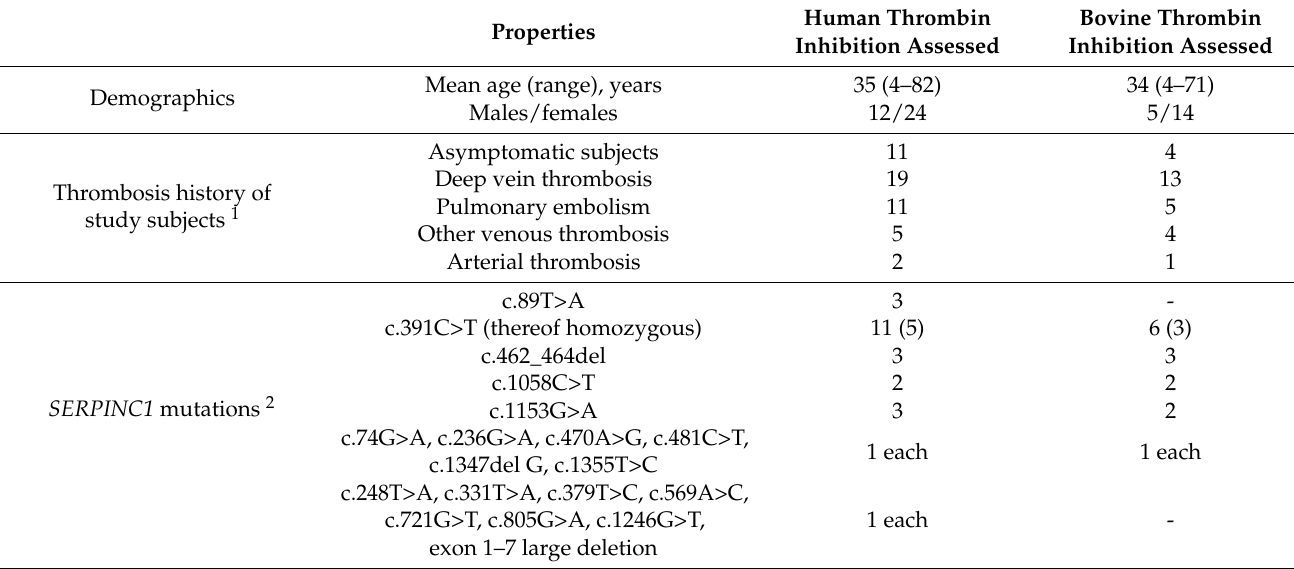
Table 1. Characteristics of the study subjects with antithrombin mutations.